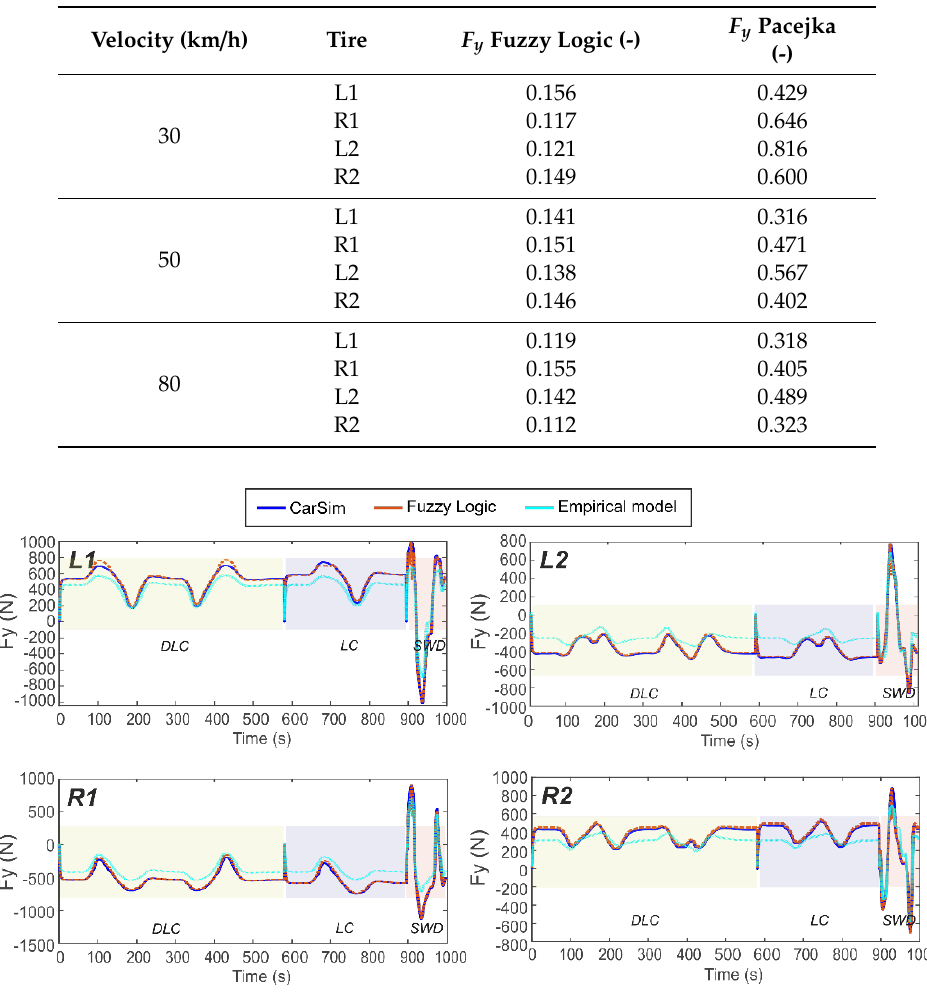
Figure 14. Comparison of the lateral force estimated by the experimental models, estimated by Fuzzy Logic and CarSim simulation at 30 km/h.